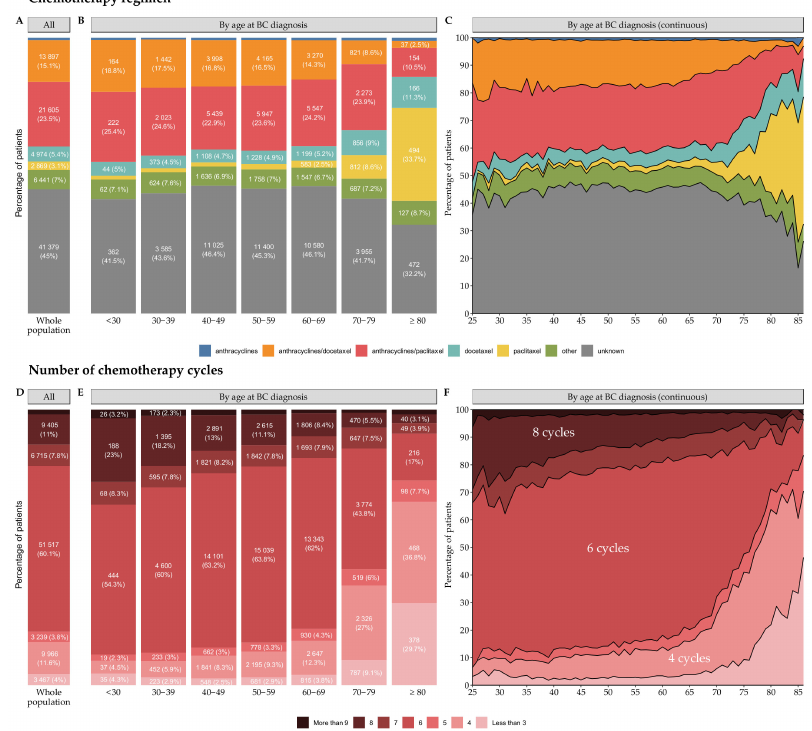
Figure 3. Chemotherapy regimen and number of cycles, by age at diagnosis. ( A ) Chemotherapy regimen for the total population ( n = 91,938). Raw data for subgroups representing less than 2% of the total population are not displayed on the graph to ensure readability. In the anthracyclines group, n = 773 (0.8%); ( B ) Chemotherapy regimen, by age class at BC diagnosis. Raw data for subgroups representing less than 2% of the corresponding age class are not displayed on the graph, to ensure readability. The values are: for the <30 years old class: n = 12 (1.4%), 30–39 years old: n = 122 (1.5%), 40–49 years old: n = 361 (1.5%), 50–59 years old: n = 485 (1.9%) for the paclitaxel group. In the <30 years old class: n < 10, 30–39 years old: n = 49 (0.6%), 40–49 years old: n = 203 (0.9%), 50–59 years old: n = 205 (0.8%), 60–69 years old: n = 202 (0.9%), 70–79 years old: n = 90 (0.9%), and ≥ 80 years old: 17 (1.2%) for the anthracyclines group; ( C ) Chemotherapy regimen, by age at BC diagnosis. The cohort is restricted to patients aged from 25 to 86 years ( n = 91,750); ( D ) Number of chemotherapy cycles for the total population. The number of chemotherapy cycles was calculated by setting ( n = 85,752). A patient with six cycles of neoadjuvant chemotherapy followed by four cycles of adjuvant chemotherapy was counted as having both six cycles and four cycles of treatment. Settings with missing numbers of chemotherapy cycles are not displayed ( n = 6186). Raw data for subgroups representing less than 2% of the total population are not displayed on the graph, to ensure readability: 1443 (1.7%) settings are in the more than 9 cycles group; ( E ) Number of chemotherapy cycles by age class ( n = 85,752) at BC diagnosis. Raw data for subgroups representing less than 2% of the corresponding age class are not displayed on the graph, to ensure readability. The values are: for the 40–49 years old class: n = 441 (2.0%), 50–59 years old: n = 412 (1.7%), 60–69 years old: n = 271 (1.3%), 70–79 years old: n = 98 (1.1%), and ≥ 80 years old: n = 22 (1.7%) for the more than 9 cycles group; and ( F ) Chemotherapy regimens by age at BC diagnosis. The cohort is restricted to patients aged from 25 to 86 years ( n = 85,589). Abbreviations: BC = breast cancer, More than 9 = more than 9 cycles, 8 = 8 cycles, 7 = 7 cycles, 6 = 6 cycles, 5 = 5 cycles, 4 = 4 cycles, Less than 3 = less than 3